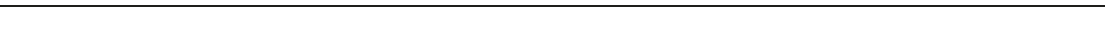
Fig. 7 Histone H3K79Hcy regulates the expressions of NTDs related genes. a ChIP-seq (upper) and RNA-seq (bottom) analysis on Smarca4 , Cecr2 , and Dnmt3b genes in control and HTL-treated NE4C cells. b ChIP-qPCR analysis of histone H3K79Hcy enrichment on Smarca4 , Cecr2 , and Dnmt3b genes in control and HTL treated NE4C. Data represent mean ± SEM ( n = 3). * p <0.05, ** p <0.01, *** p <0.001 vs. control NE4C groups; the p values were calculated with unpaired t test. c ChIP-qPCR analysis of histone H3K79Hcy enrichment in different regions of Smarca4 in NE4C and HTL treated NE4C cells. Region 1 is at 8000 bp upstream of the Smarca4 gene; Region 2 is the gene body of Smarca4 ; Region 3 is at 8000 bp downstream of the Smarca4 gene. Data are represented as means ± SEM ( n = 3); * p < 0.05 vs. with controls, the p values were calculated with unpaired t test. d RT-PCR analysis on gene expression of Smarca4 , Cecr2 , and Dnmt3b in control and HTL treated NE4C. Data represent mean ± SEM ( n = 3). ** p <0.01, **** p <0.0001 vs. control NE4C groups; the p values were calculated with unpaired t test. e Aberrant expression of histone H3K79Hcy in high-Hcy NTDs. Left panel: Hcy levels in 10 normals and 10 NTDs from human fetal brain tissues; Column normals: 3.322 ± 0.4988 (pmol/mg), n = 10; Column NTDs: 41.00 ± 3.705 (pmol/mg), n = 10; **** p < 0.0001 vs. normal brain tissues. Middle panel: Western blotting of H3K79Hcy modi fi cation from normal and NTDs human fetal brain tissues; Right panel: Quanti fi cation of the western blotting signal intensity shown in scatter plot. Column normals: 0.3033 ± 0.02914, n = 10; Column NTDs: 0.4368 ± 0.04549, n = 10; * p = 0.0237, NTDs vs. normal brains. The p values were calculated with unpaired t test. f Nanostring analysis of mRNA level of SMARCA4 , CECR2 , and DNMT3B in 10 normals and 10 NTDs human fetal brain tissues. SMARCA4 normals: 3943 ± 345.5, SMARCA4 NTDs: 2577 ± 158.6; P = 0.0021; CECR2 normals: 724.5 ± 60.35, CECR2 NTDs: 501.2 ± 47.12, P = 0.0092; DNMT3B normals: 191.2 ± 22.71, DNMT3B NTDs:106.5 ± 19.66, P = 0.0114. * p